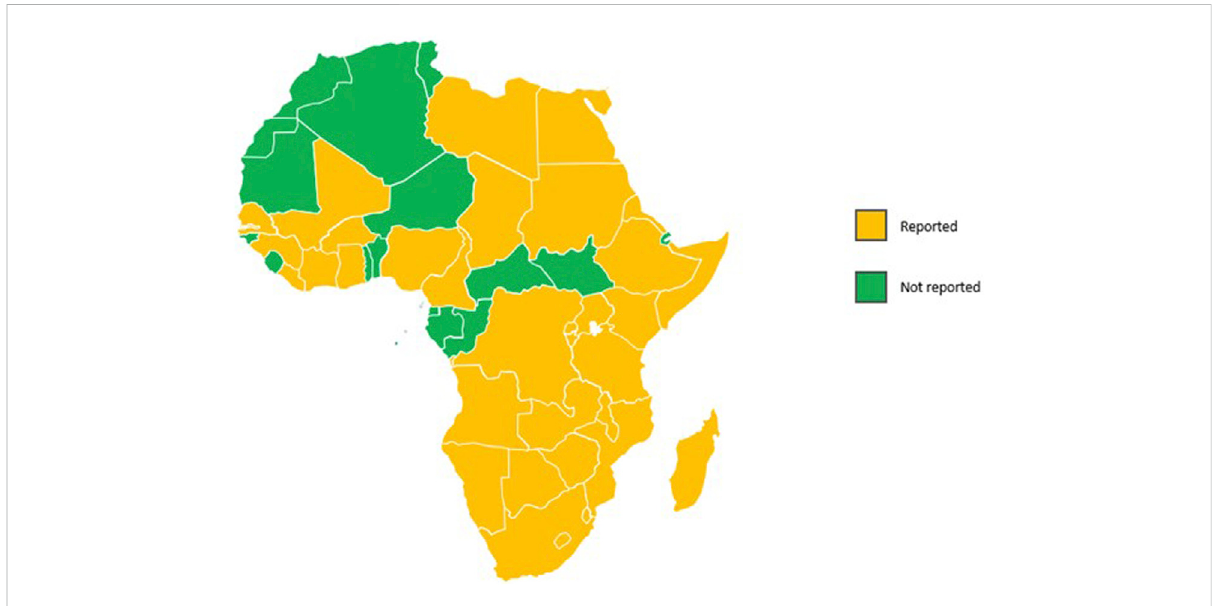
FIGURE 1 Map of Africa showing the presence of the Jersey